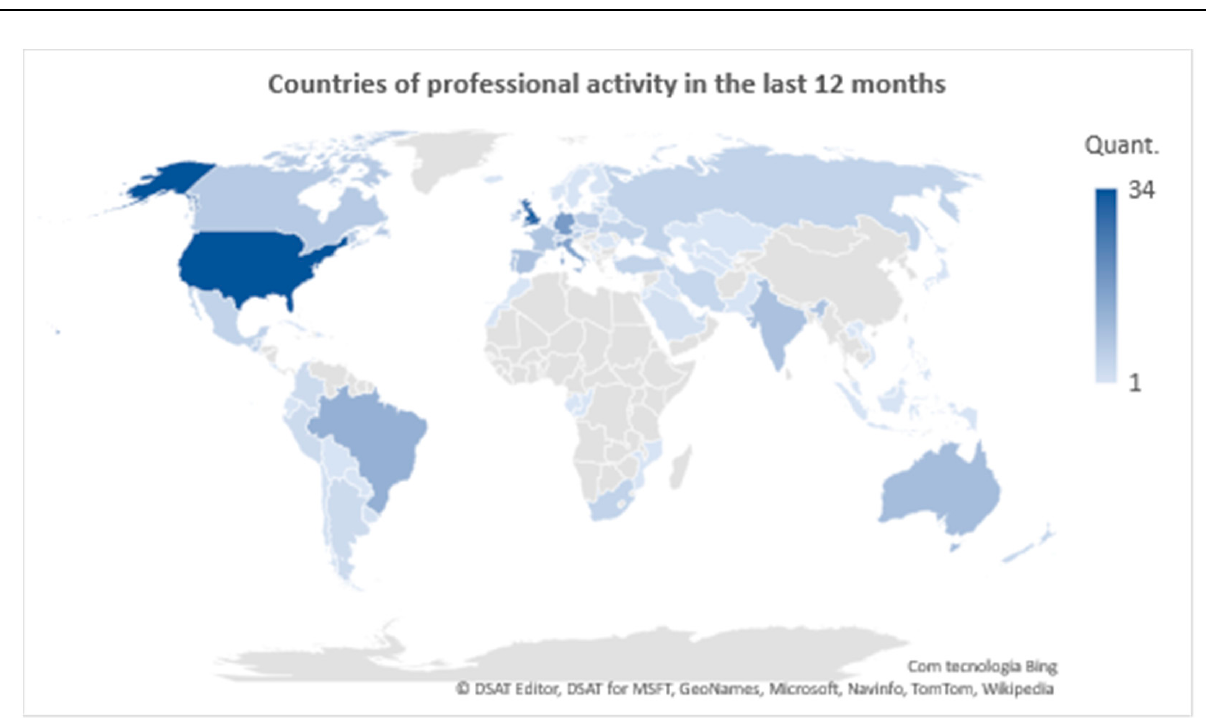
Figure 2. Illustrative map of the countries of the professional activity of the participants in the last 12 months. This research chose to use the seven continents division model to categorize the interviewees’ placement. Data from transcontinental countries such as Russia, Turkey, and Kazakhstan were grouped in the Europe and Asia category, as it is not possible to identify which part of the country (Asia or Europe) the participants in question reside and